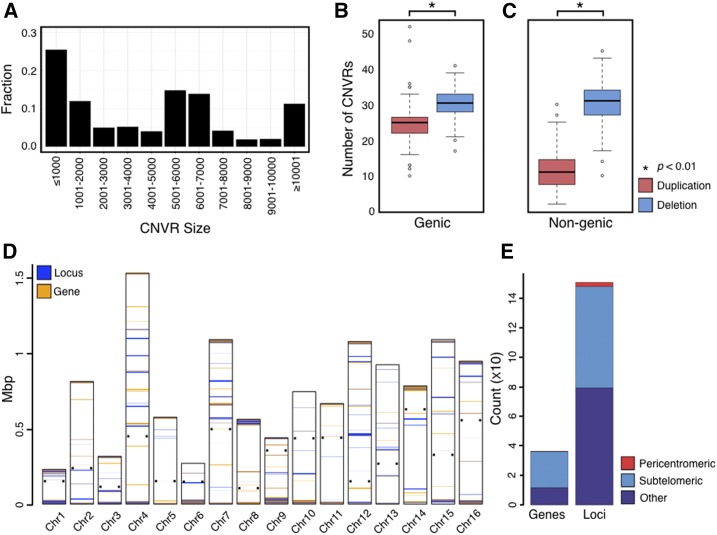
Size distribution and location of CN variable loci. (A) The fraction of CNVRs (y-axis) for a given size range. Most CNVRs are ≤1000 bp. (B, C) Deleted genic (B) and nongenic (C) CNVRs are more prevalent than duplicated ones (P < 0.01 for both comparisons). Note that 26.23% of genic duplications occurred in multiples of three. (D) Location of CN variable loci across the 16 yeast chromosomes. The small, black squares on either side of each chromosome denote centromere location. Chromosomes are oriented with the start of the chromosome on the bottom and the end on top. Loci (blue bars) and genes (orange bars) harboring high log10(s2) or PIC values are shown. (E) A total of 684 of the 1502 CN diverse loci and 243 of the 363 CN diverse genes reside in subtelomeric regions of the yeast genome; in contrast, very few are found in pericentromeric regions (28 loci and three genes).